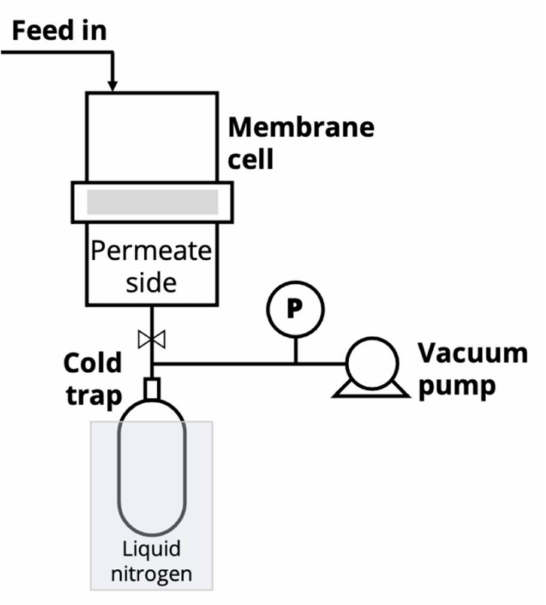
Figure 12. Schematic of the laboratory-scale pervaporation